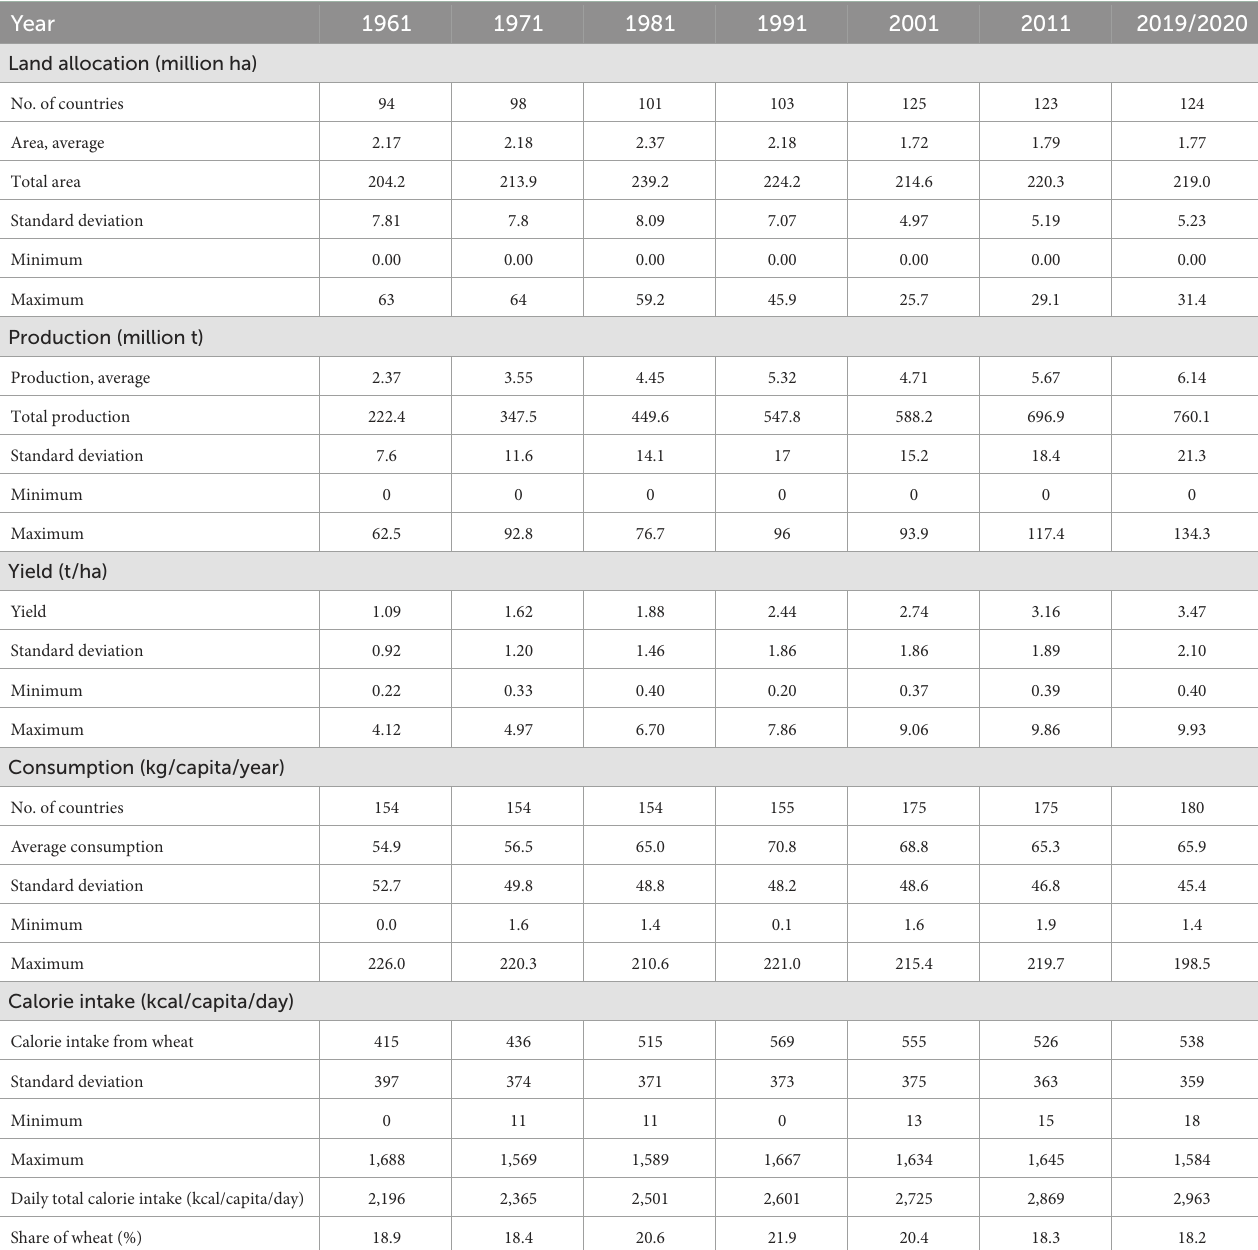
TABLE 1 Temporal changes in wheat production and consumption in the world